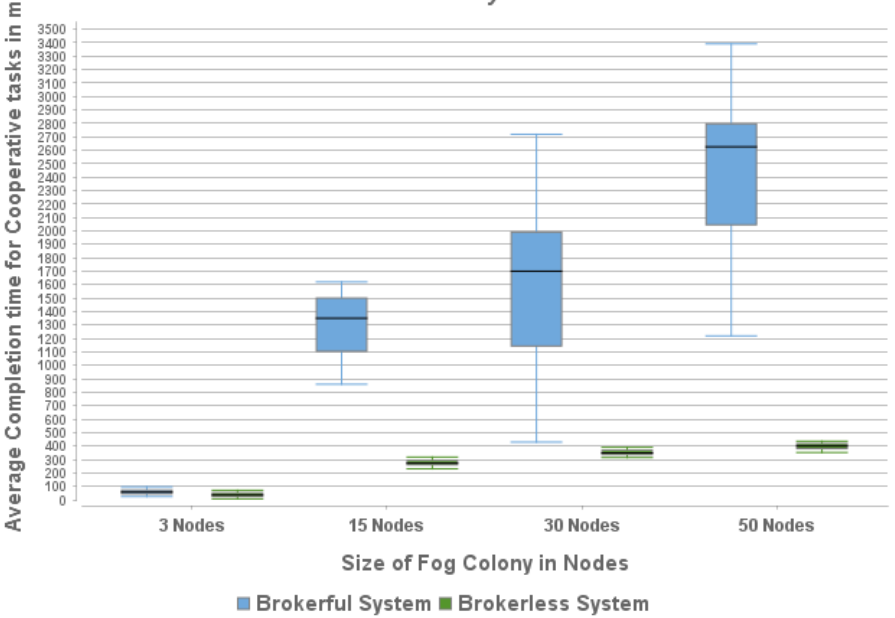
Figure 7. Box chart showing the comparison on the completion time for cooperative task execution between the two Fog Colony Architectures.